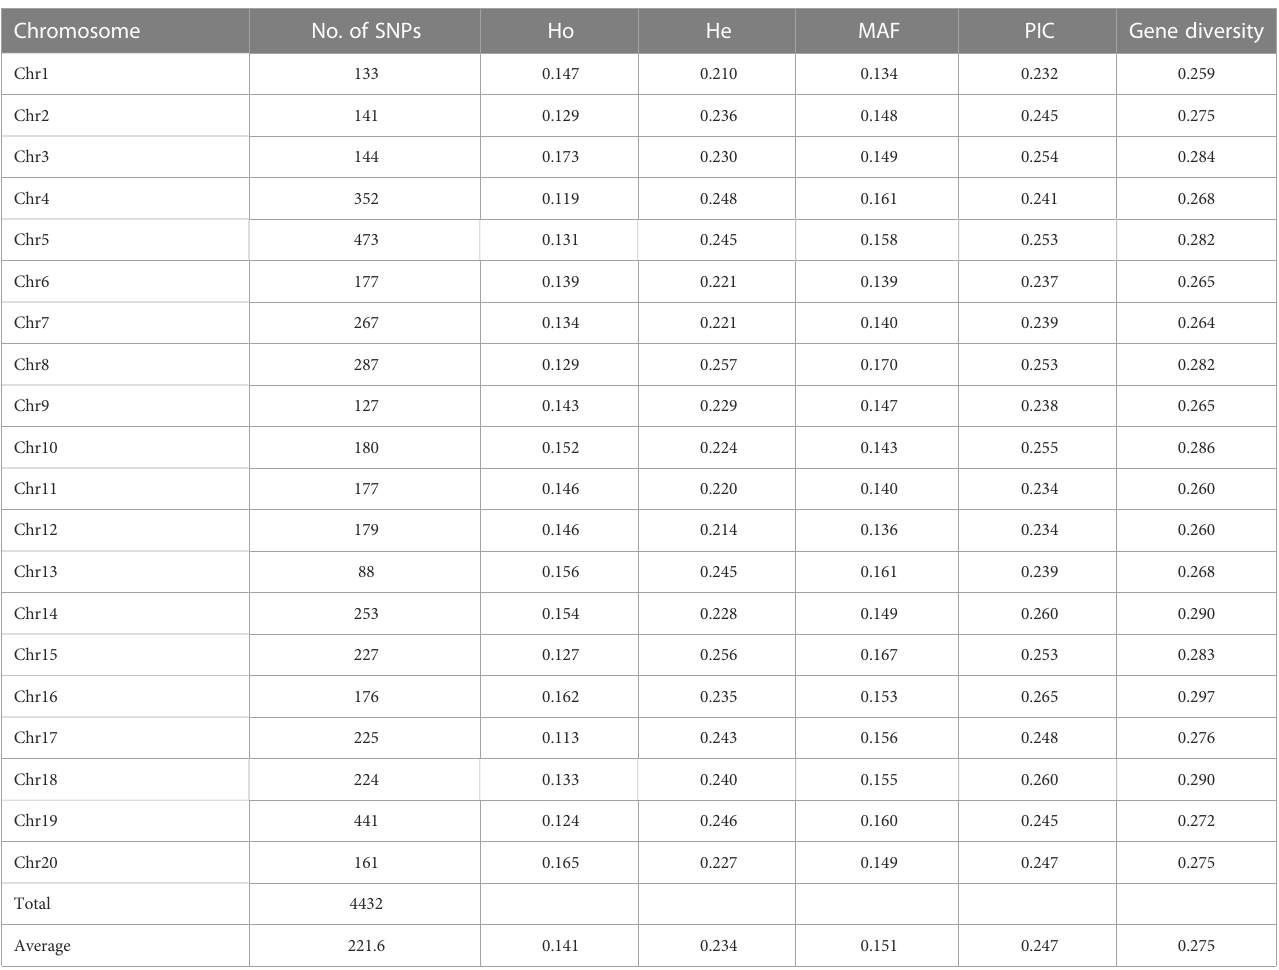
TABLE 2 Summary statistics of SNP markers across 20 white Guinea yam